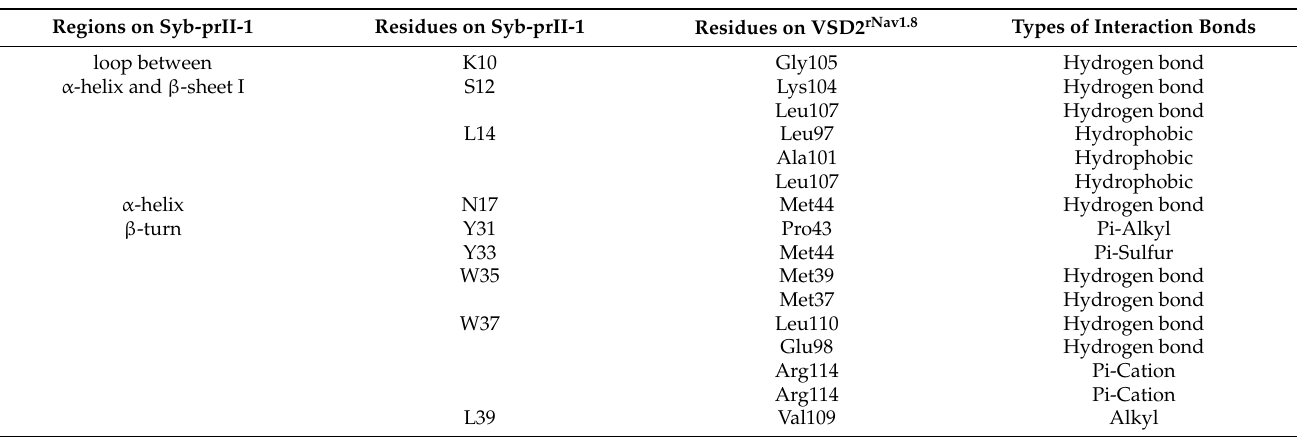
Figure 9. ( A ) RMSD curves of the complex systems of VSD2 rNav1.8 ‐ Syb ‐ prII ‐ 1. ( B ) The structure of the complexes in the membrane after MD simulation. Binding modes of related residues on IS1 ( C ) and IS2 ( D ) Names of residues on the peptide are in black; names of residues on VSD2 rNav1.8 are in red. Table 1. Residues involved in the binding surface of VSD2 rNav1.8 ‐ Syb ‐ prII ‐ 1 and the types of interaction bonds.